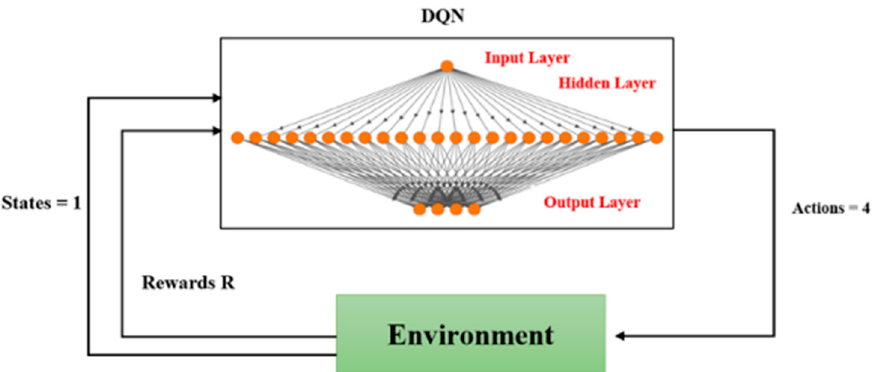
Figure 6. Architecture of Deep Q-Network for Path